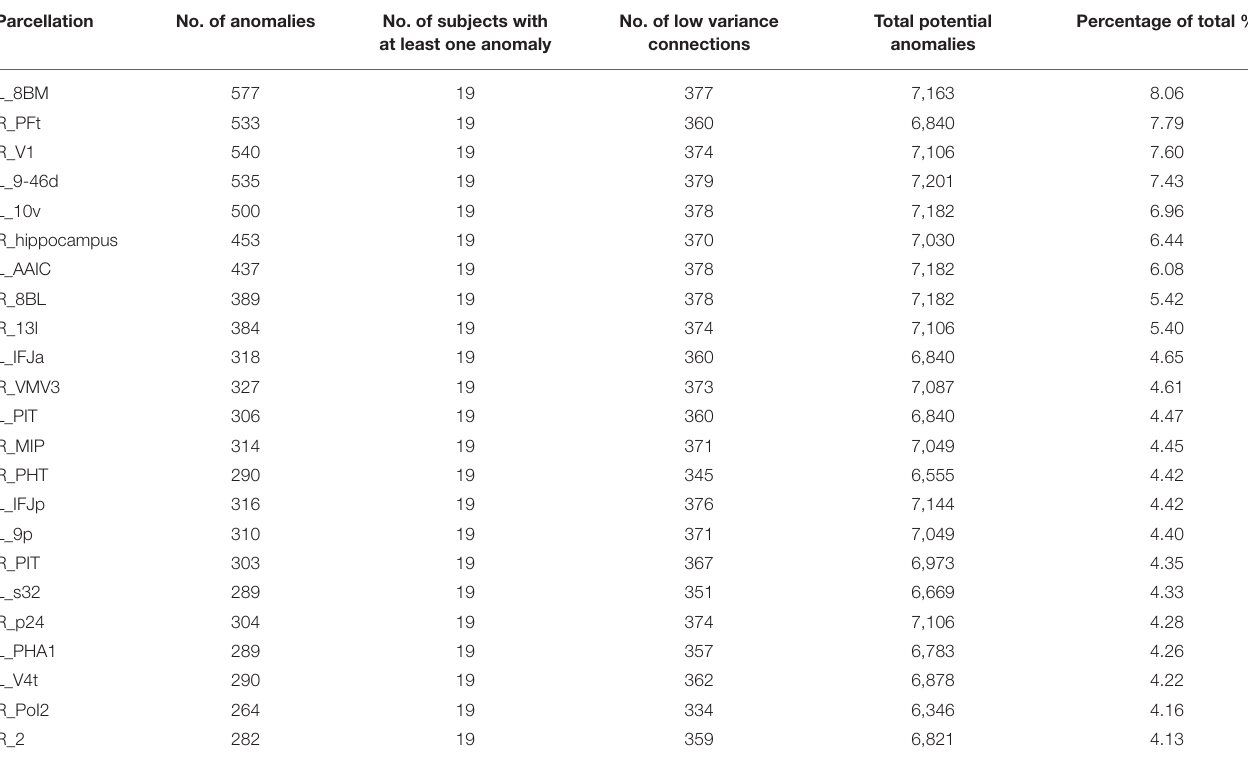
TABLE 3 | Functional anomaly burden.